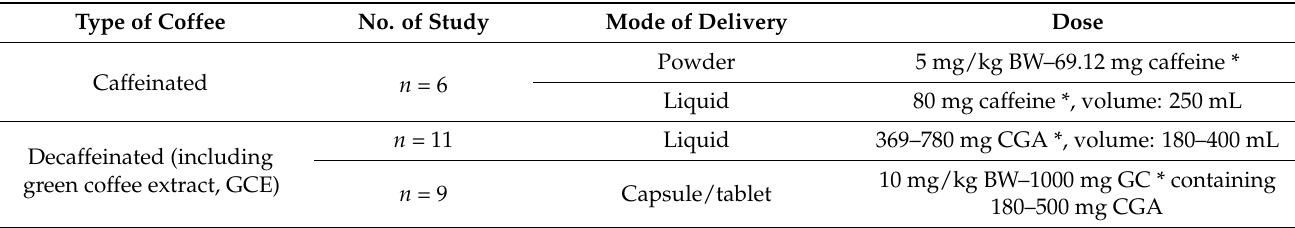
Table 2. Summary findings on coffee types and doses used in RCTs.